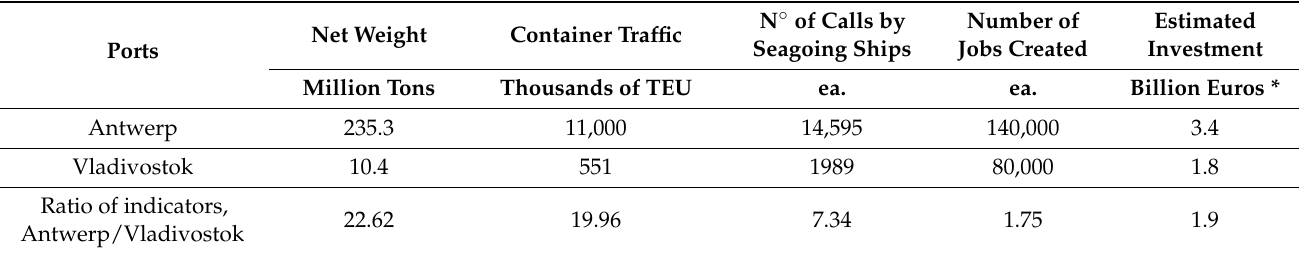
Table 5. Comparison between the port of Antwerp and the free port of Vladivostok characteristics in 2018. N ◦ of Calls by Number of Estimated Net Weight Container Traffic Seagoing Ships Jobs Created Investment Ports Million Tons Thousands of TEU ea. ea. Billion Euros * Antwerp 235.3 11,000 14,595 140,000 3.4 Vladivostok 10.4 551 1989 80,000 1.8 Ratio of indicators, 22.62 19.96 7.34 1.75 Antwerp/Vladivostok